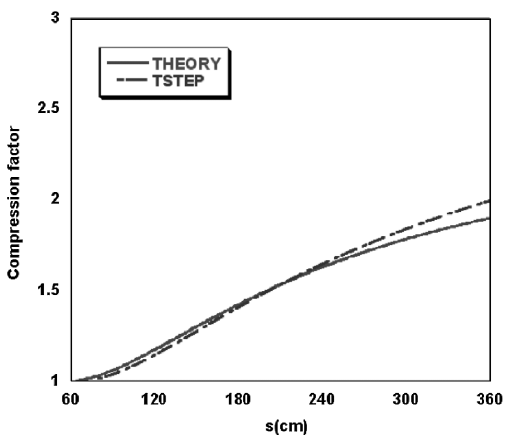
FIG. 10. Compression factor along the beam line ( TSTEP simu- lations vs linear theory) for rf phase (cid:2)